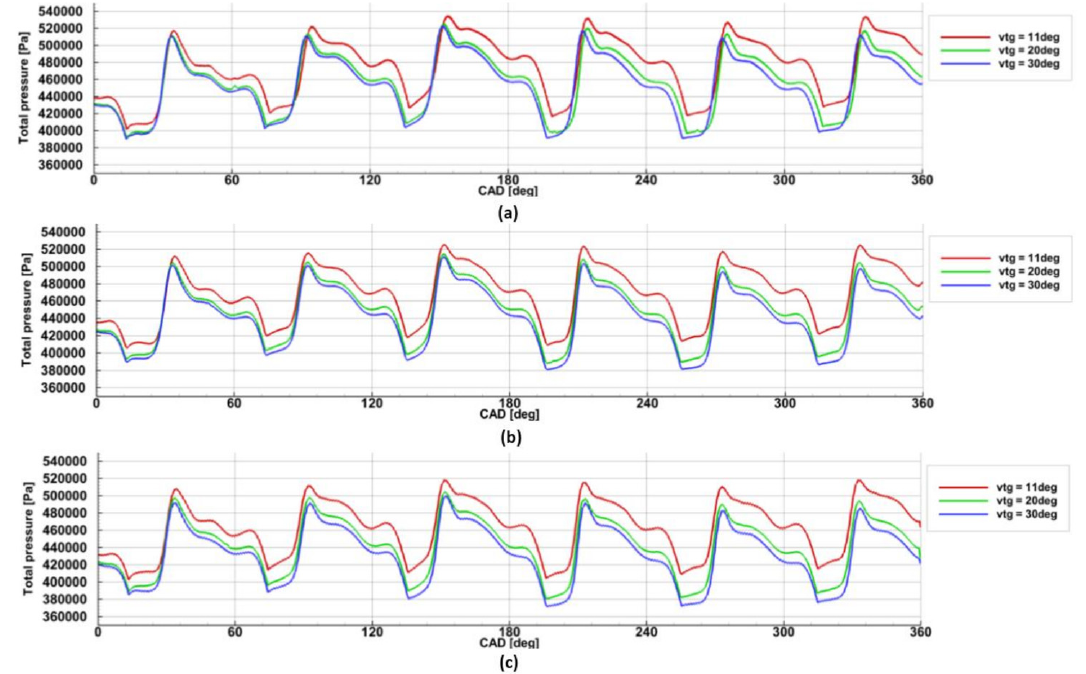
Figure 16. The intersection of the pressure plot monitored at the Section 6.1 for the three different VTG opening at the turbine speed: ( a ) 60,000 rpm, ( b ) 50,000 rpm, ( c ) 40,000